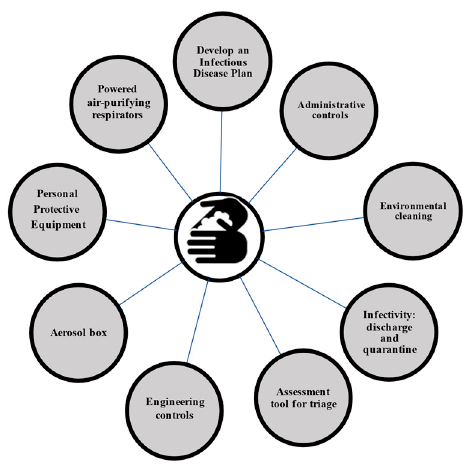
Figure 2. Infection prevention and control cornerstones in COVID-19.